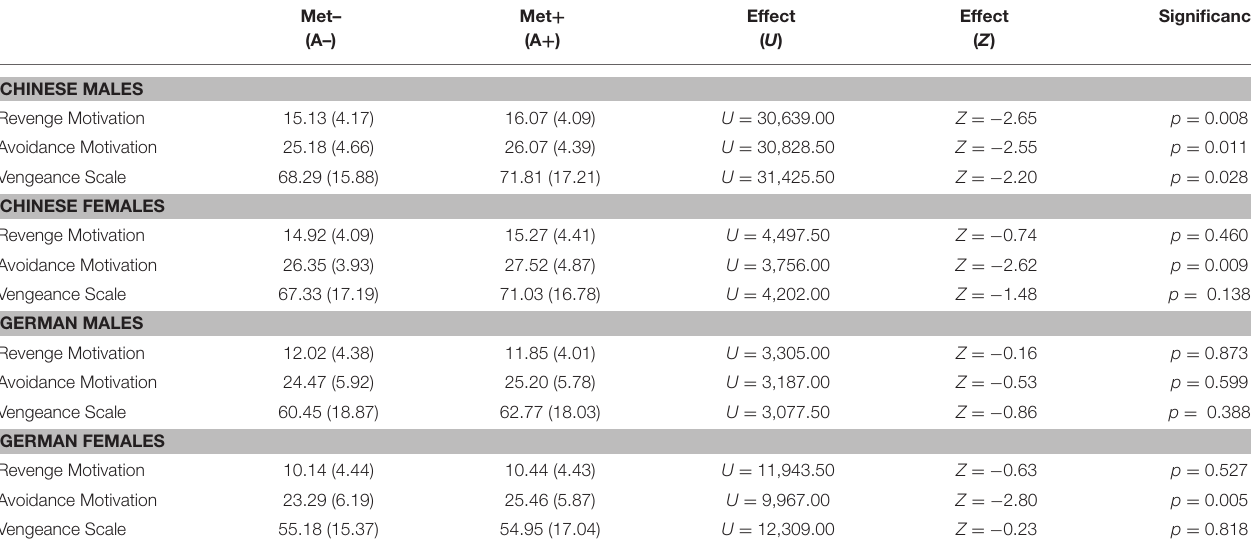
TABLE 4 | Effects of the COMT Val158Met polymorphism (on allele level) on all scales under investigation split by nation and